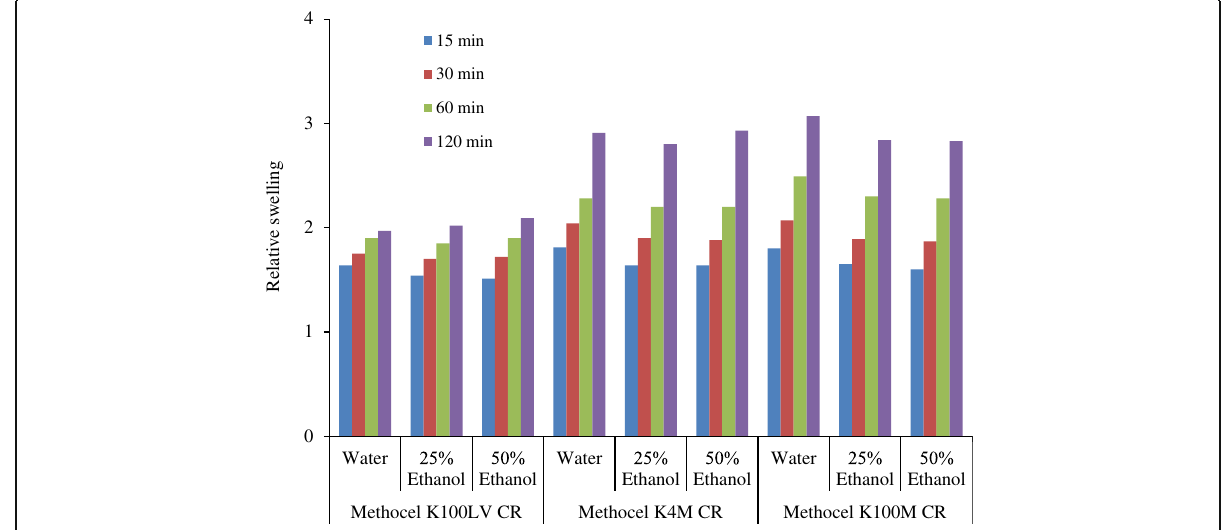
Fig. 23 Effect of hydroalcoholic media on relative swelling of methocel compacts (data from reference (Levina et al. 2007))